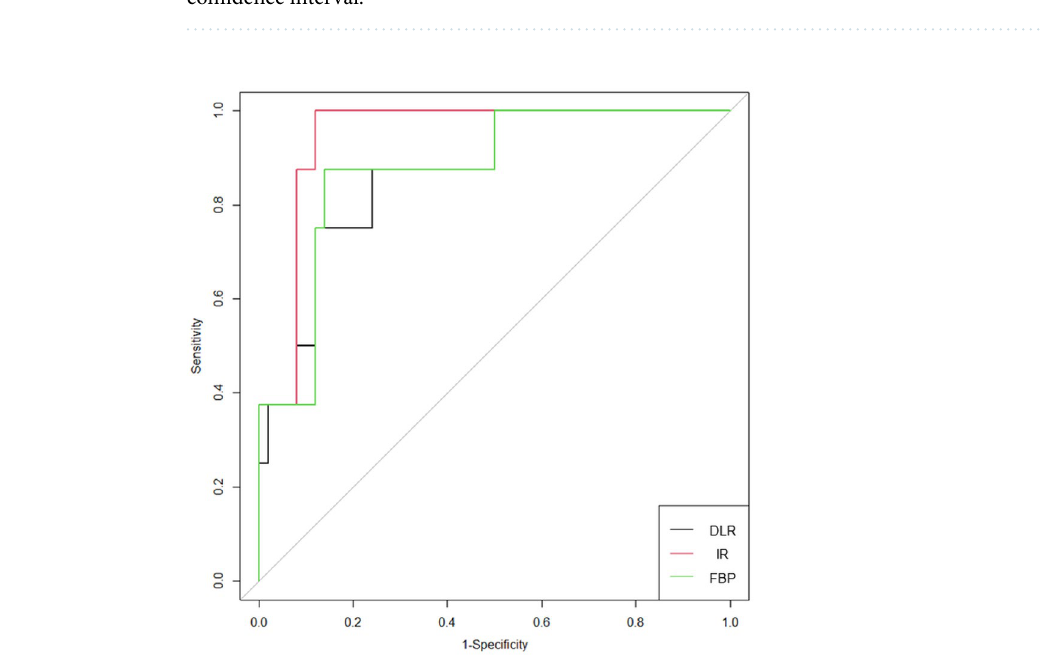
Table 2. Specifications of the radiomics scores obtained by and radiomics model performance for each reconstruction method. Rad-score, radiomics score; DLR, deep learning-based reconstruction; IR, iterative reconstruction; FBP, filtered back projection; AUC, area under the receiver operating characteristic curve; CI, confidence interval.